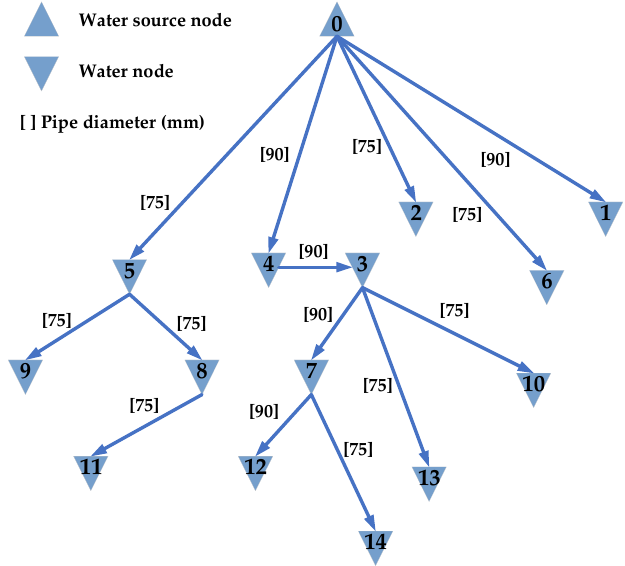
Figure 4. Optimal design result of the pipe network based on the ICSO-ASV algorithm (15 nodes).